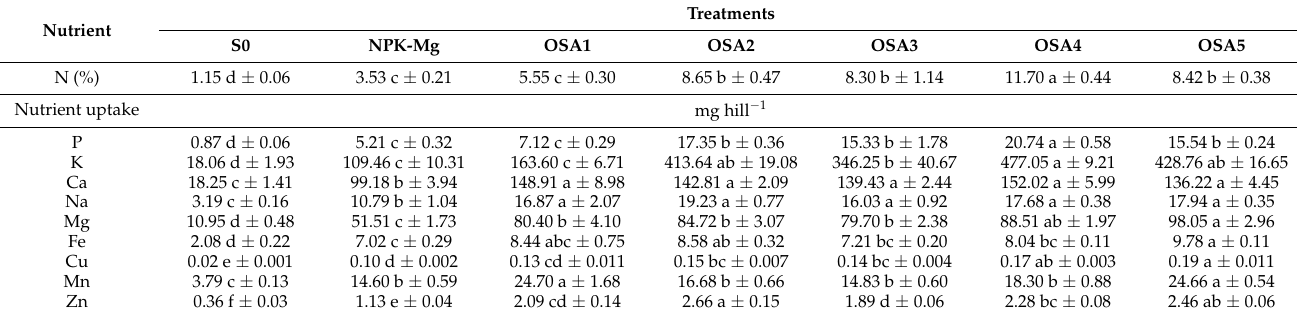
Table 8. Total nitrogen and nutrients uptake by MR219 rice plants as affected by organic soil amendments during the first cropping